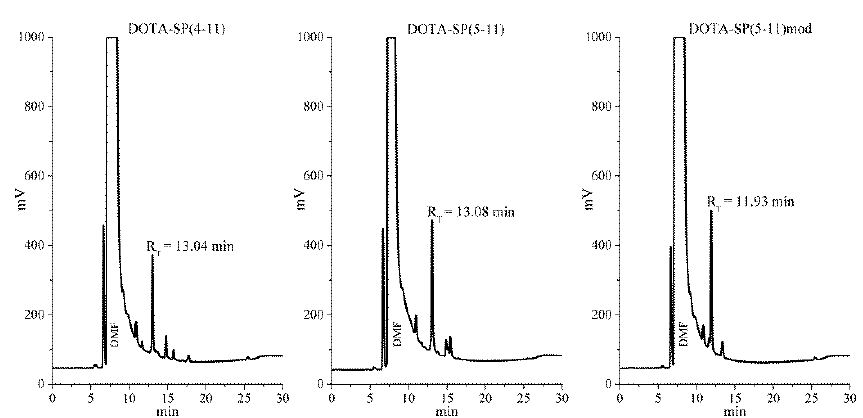
Scheme 2. Coupling reaction of DOTA-NHS with SP fragments.